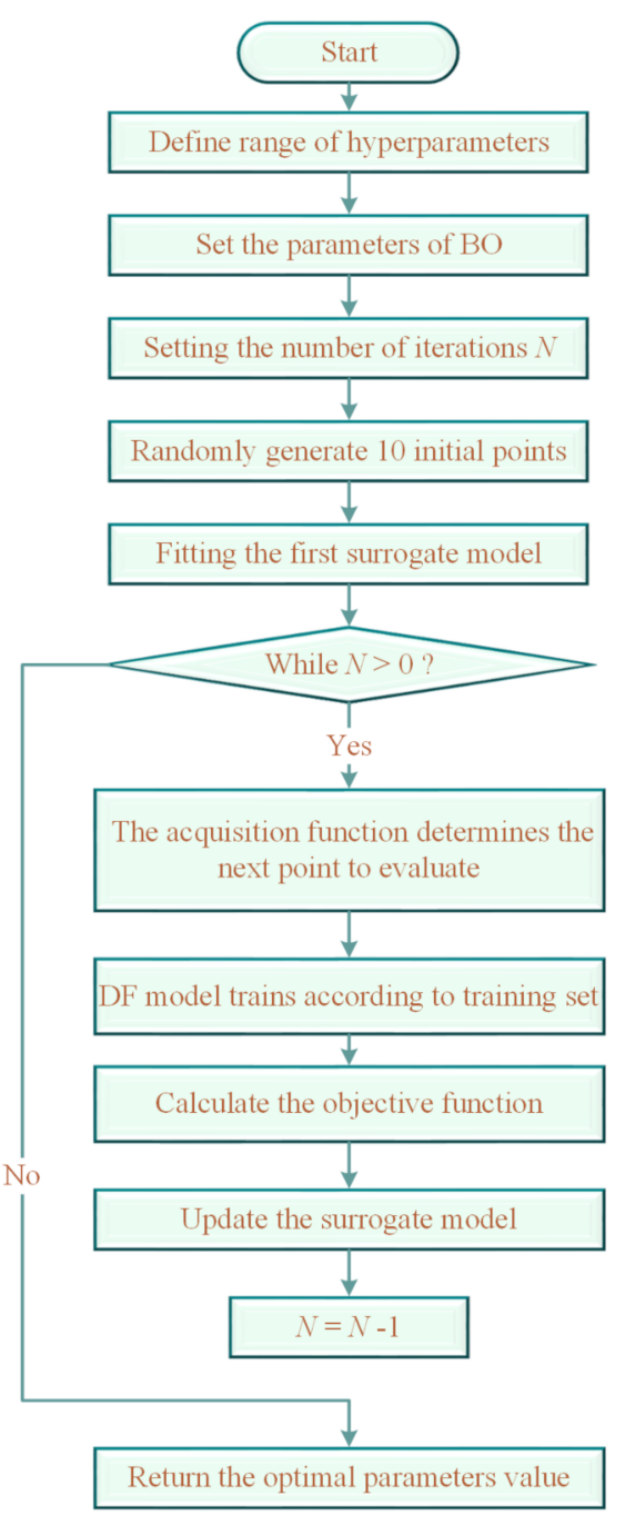
Figure 7. The flowchart of